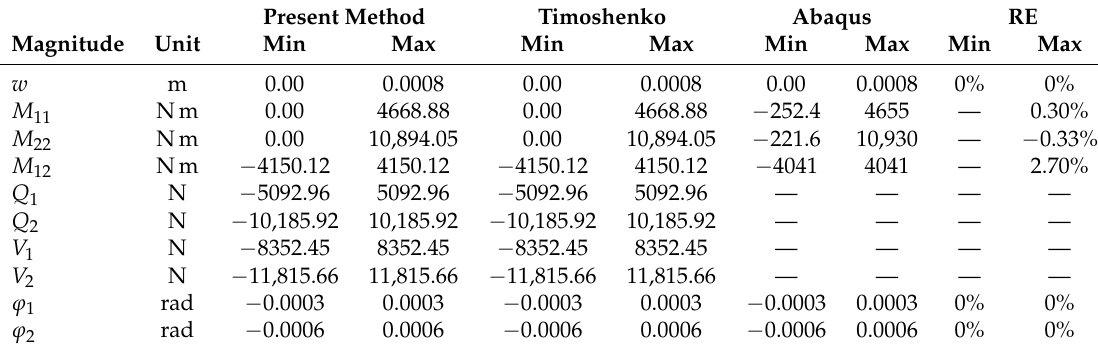
Table 3. Minimal and maximal values of magnitudes with their relational error (RE).